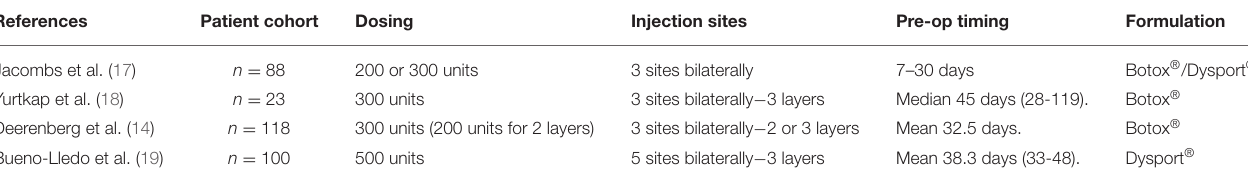
TABLE 1 | BTX dosing at a glance; a list of recently published articles on BTX use and their treatment